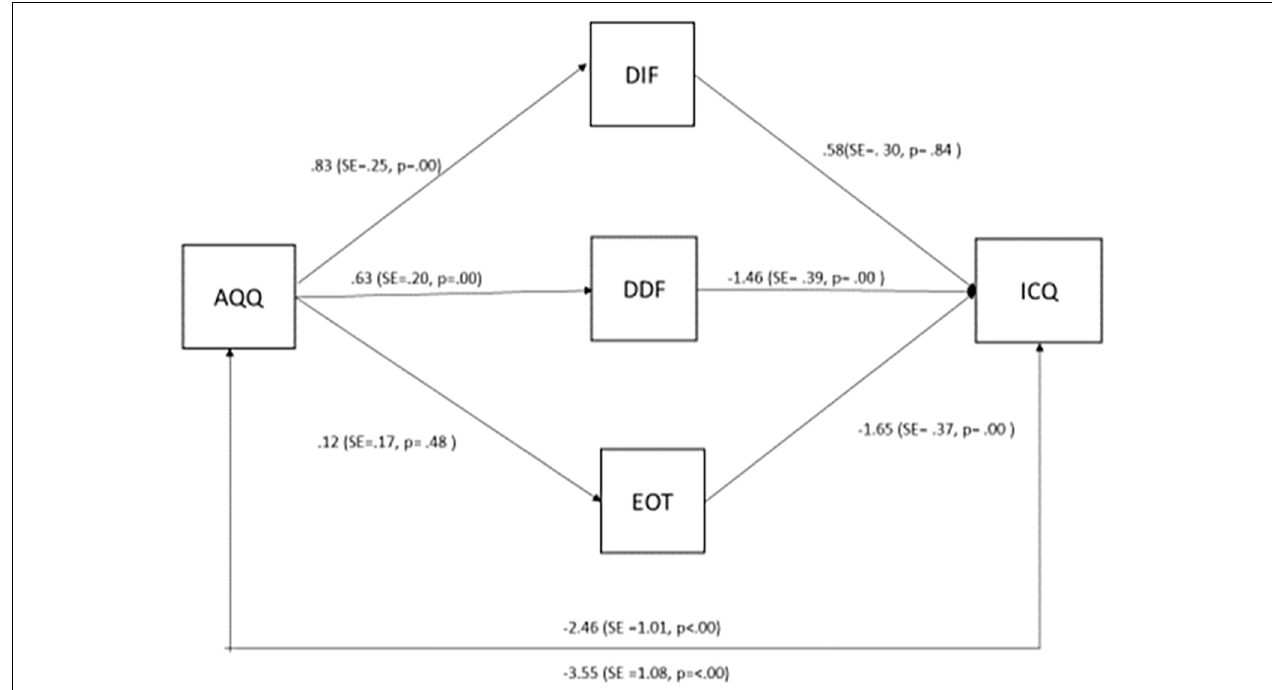
FIGURE 2 | Structural equation model 1.